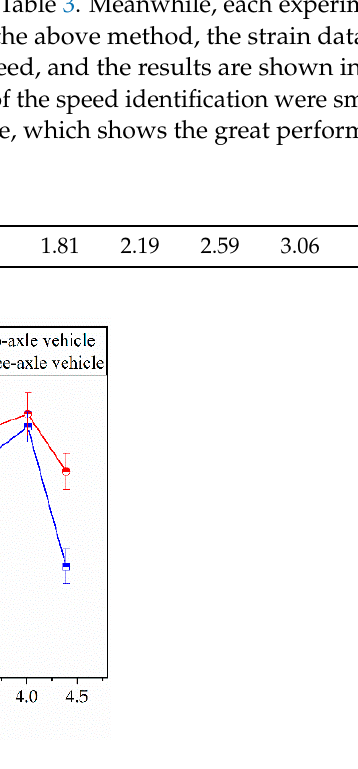
Figure 15. Relative error of the speed identification.